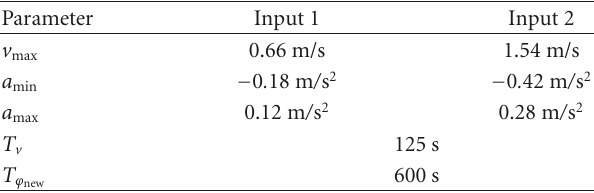
Table 3: Parameter values for mobility